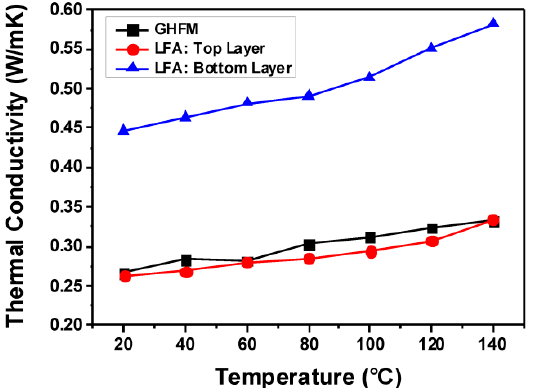
Figure 8. Comparison of the guarded heat flow meter (GHFM) (representing a homogenized bulk material) and the LFA measurements (representing the respective layers of a gradient composite numbered 2 and 8) of the epoxy resin-based composite.